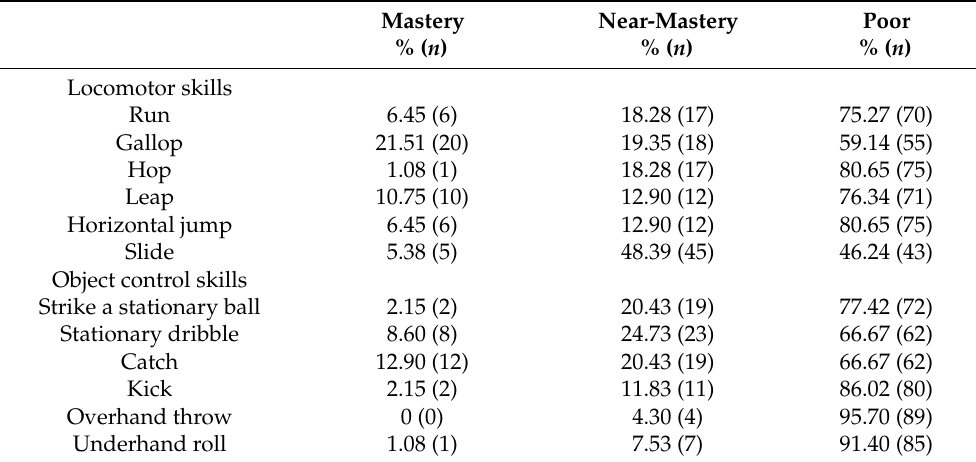
Table 2. Proportion of participants displaying mastery/near-mastery/poor proficiency of locomotor and object control